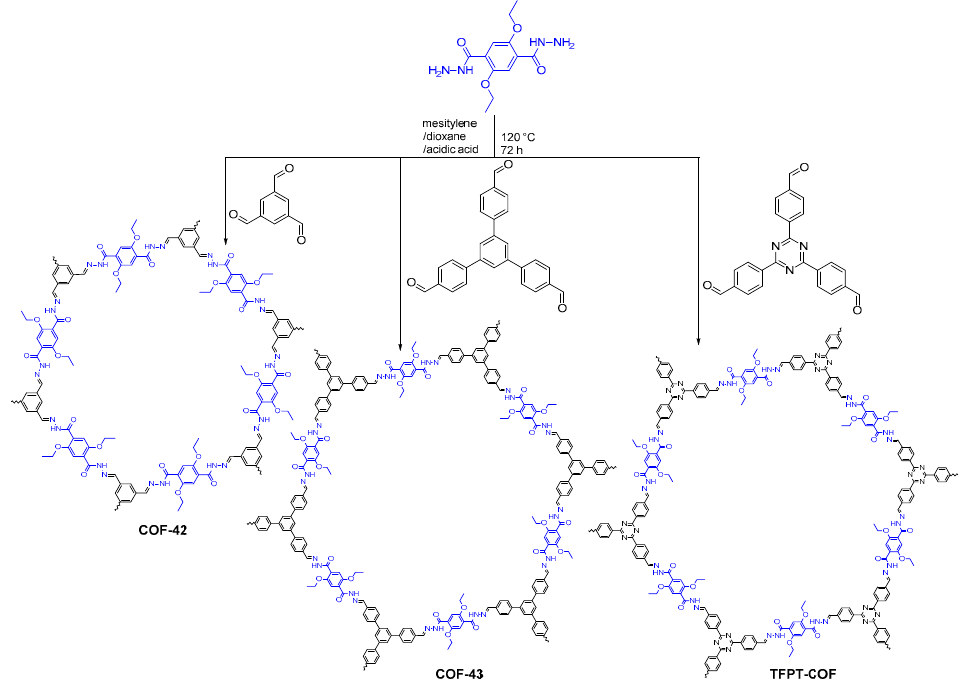
Figure 19. Synthetic reaction of hydrazone-linked COFs (COF-42, COF-43, and TFPT-COF).